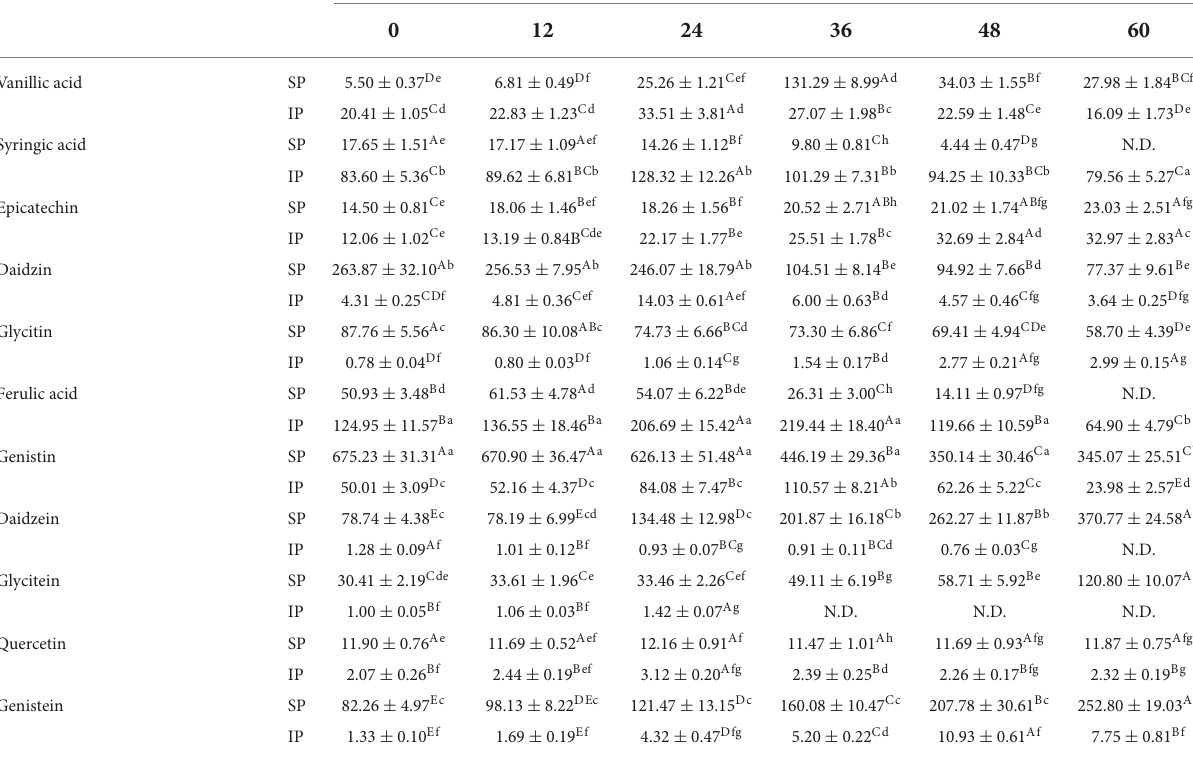
TABLE 1 Contents of the phenolic compounds in soybeans during SSF. Phenolic components (ug/g)